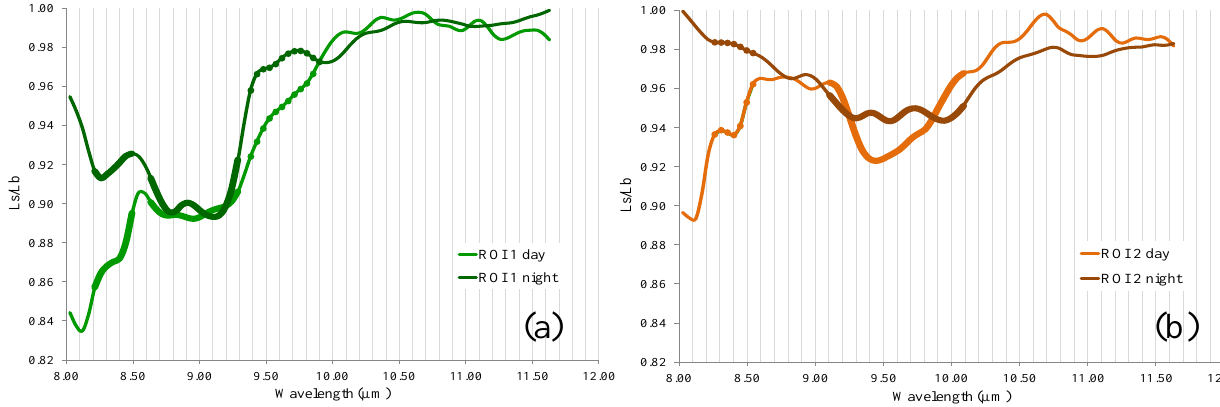
Figure 4. Day and night Ls/Lb spectra of ( a ) ROI 1 and ( b ) ROI 2. Different atmospheric contributions are noticeable: ozone’s daytime absorption feature vs. nighttime emission feature (( a ); dotted lines) and water vapor’s daytime absorption feature vs. nighttime emission feature (( b ); dotted lines). Similar daytime and nighttime absorption features are noticeable (( a ) and ( b ); thick lines).